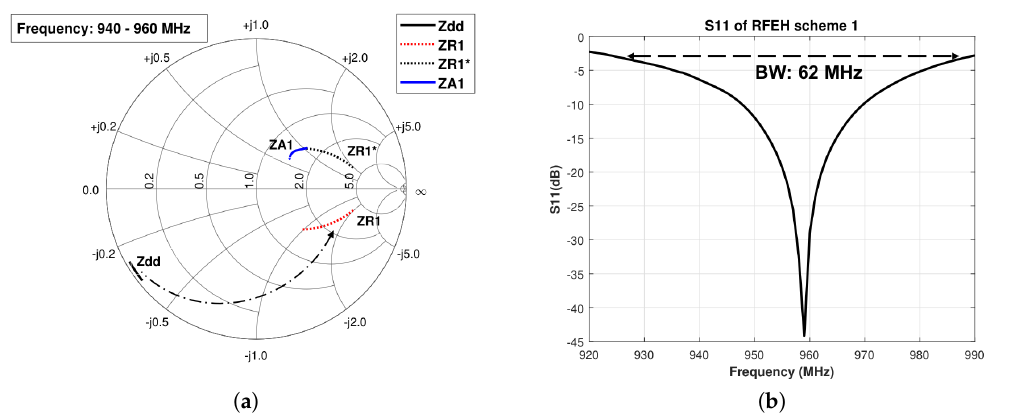
Figure 9. Measured impedance and S11 of the RFEH scheme 1: ( a ) Impedance, ( b )